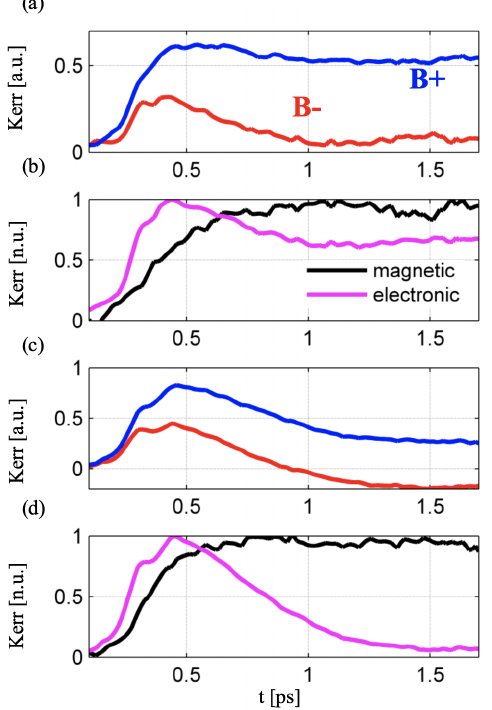
Figure 3. ( a ) The measured Kerr signal (B+ and B−) under a 9 THz filtered fluence of 48 mJ/cm 2 . ( b ) The extracted magnetic (B+ − B−) and electronic (B+ + B−) responses. ( c , d ) are the corresponding measurements to ( a , b ) under a fluence of 85 mJ/cm 2